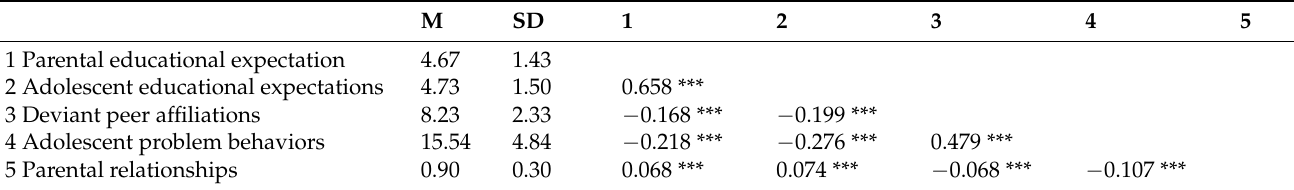
Table 1. Means, standard deviations, and Pearson correlation coefficients of main